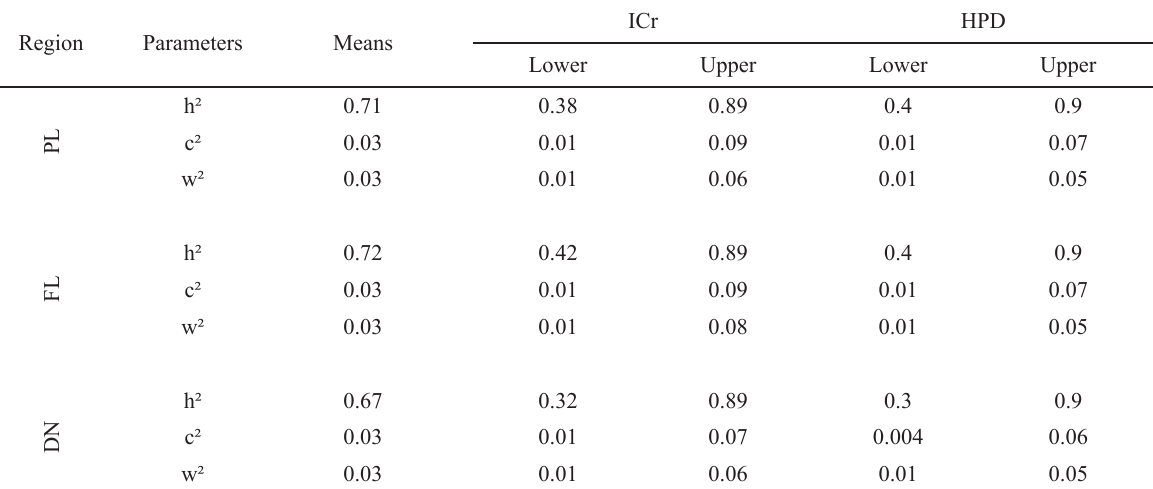
Heritability estimates (h²), participation of common environment of larvae culture (c²) and common environment of fingerlings (w²) in the phenotypic uni-characteristic